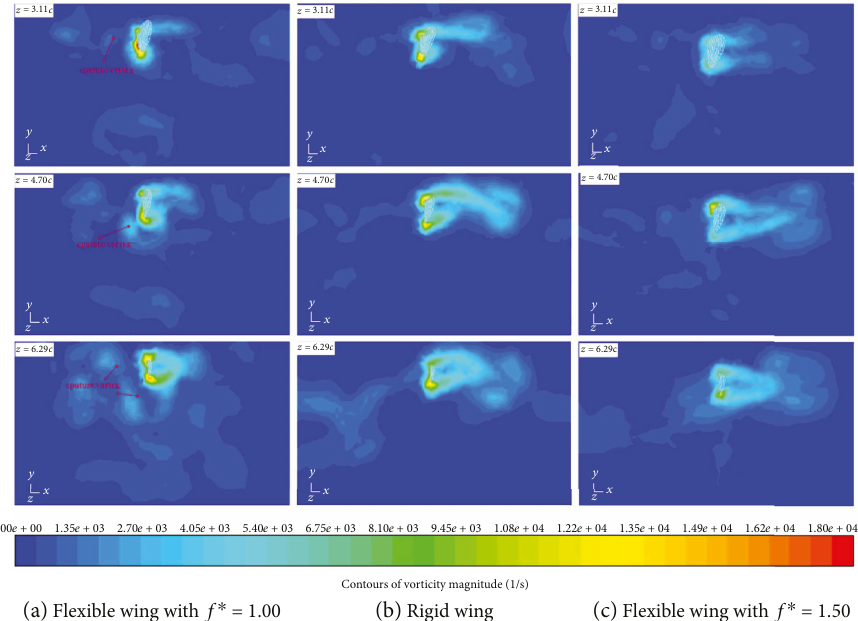
Figure 11: The vortex of the rigid and fl exible wing with f ∗ = 1 00 and 1.50 at t = 11 70 T and z =3.11 c , 4.70 c , and 6.29 c .